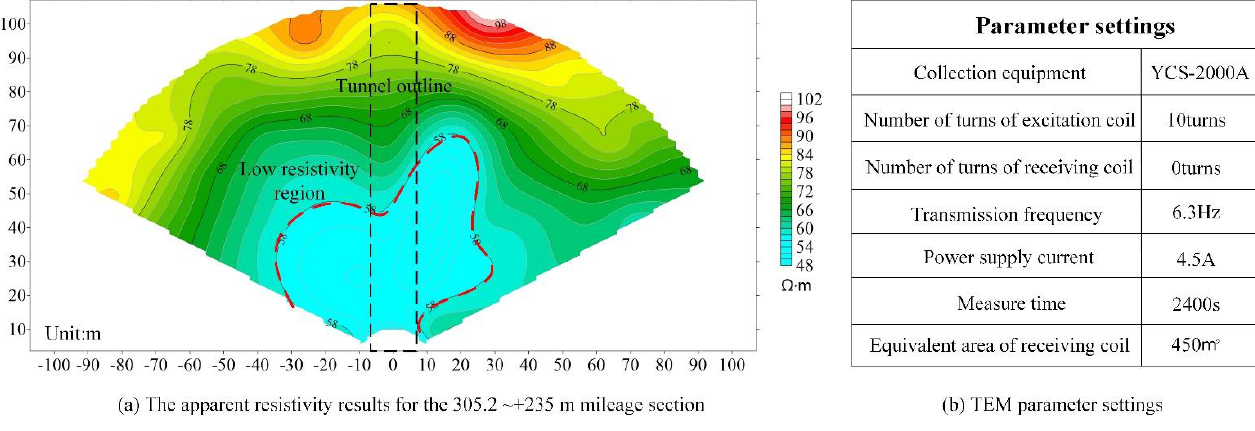
Figure 6. Transient electromagnetic prediction of the 305.2~+ 235 m mileage section.